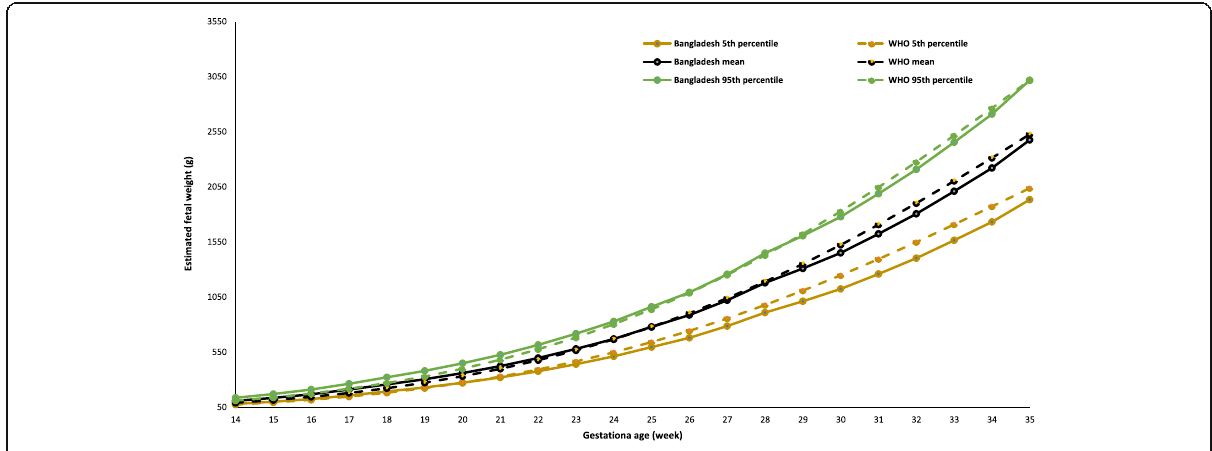
Fig. 6 Comparison of estimated fetal weight (EFW) with WHO [11] reference values up to 35 weeks ’